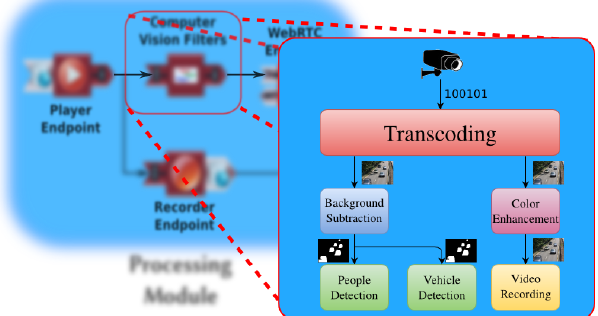
Figure 4. Example of filter logic arrangements based on Kurento’s pipeline..